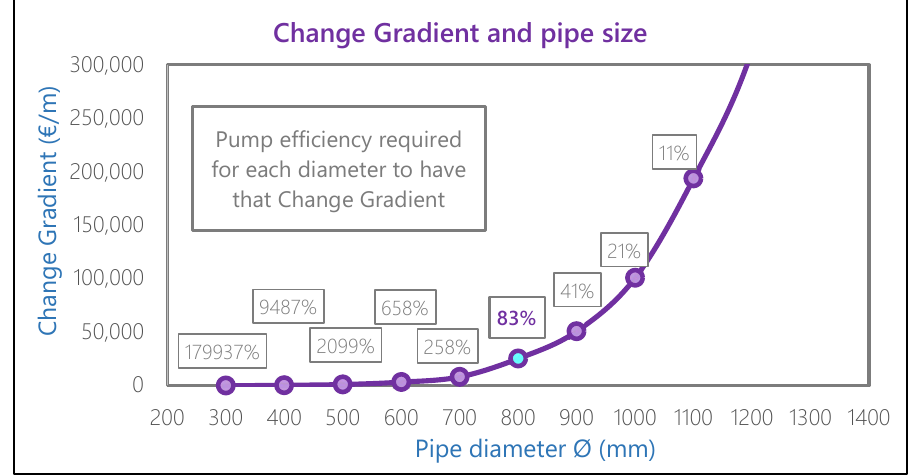
Figure 7. Change Gradient and pipe diameter in the application case.